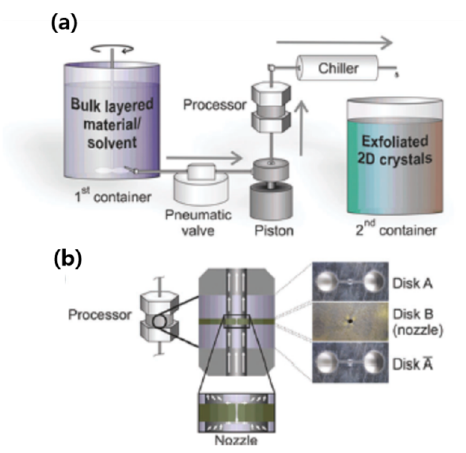
Figure 5. ( a ) Schematic of wet-jet milling system (the arrows indicate the flow direction of dispersion) and ( b ) closed view of the processor (Disk B can be varied to 0.10, 0.20, 0.30 mm nozzle diameter upon the size of the 2D nanosheets in dispersion). Reprinted with permission from reference [22], copyright 2018, Royal Society of Chemistry.